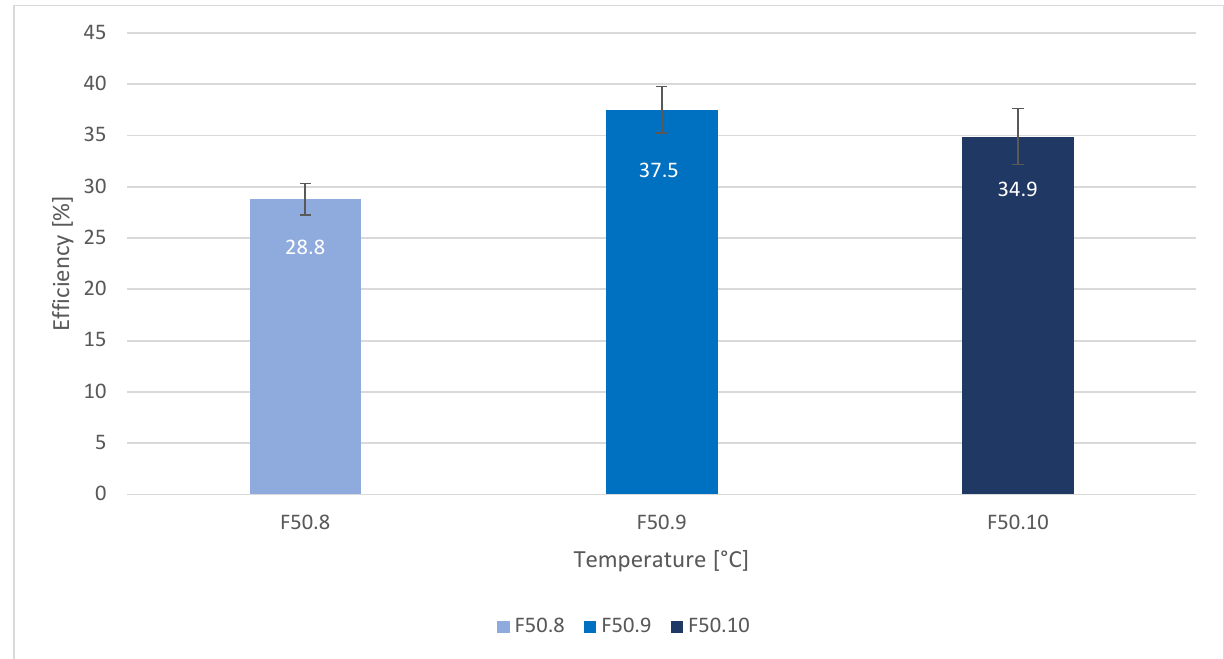
Figure 3. Efficiency % (T) of formulations containing PCC/Mg(OH) 2 at different dosages. Standard deviation ranges are reported.